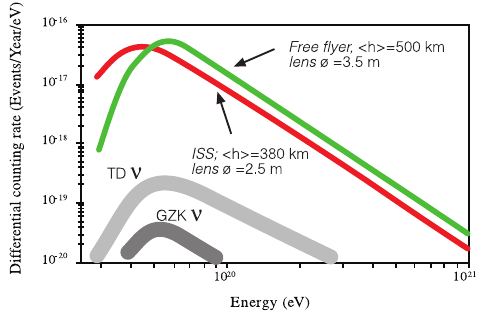
Fig. 11. The differential fl ux of neutrinos predicted using the topological defects model of Sigl et al. (1999) and the GZK model of Stecker et al. (1991).